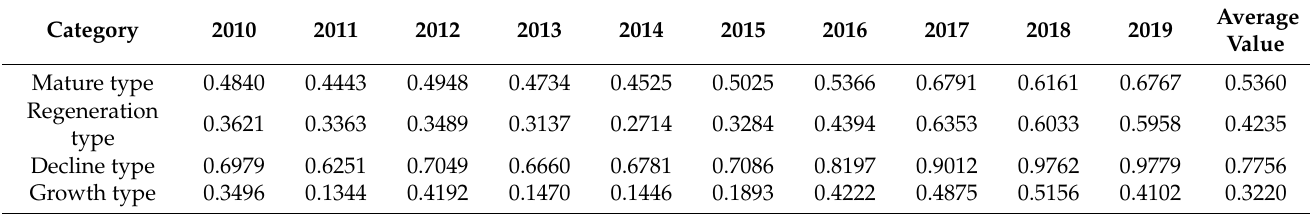
Table 5. Average values of green innovation efficiency by type of resource-based cities